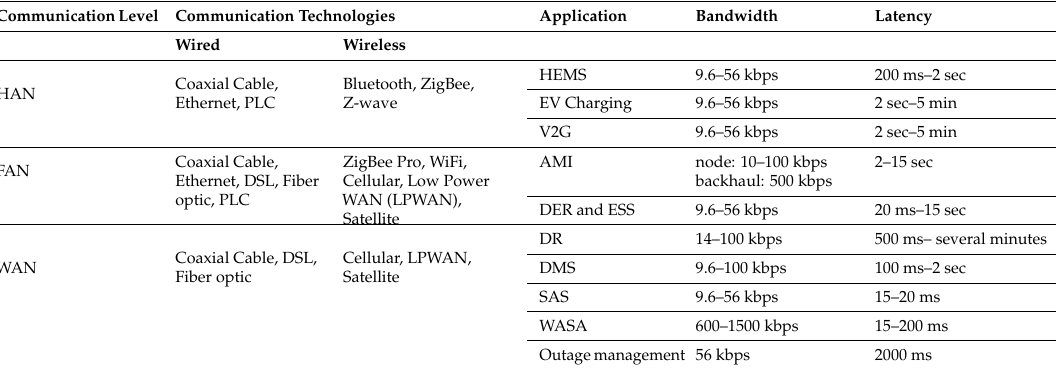
Table 2. Bandwidth and latency in the smart